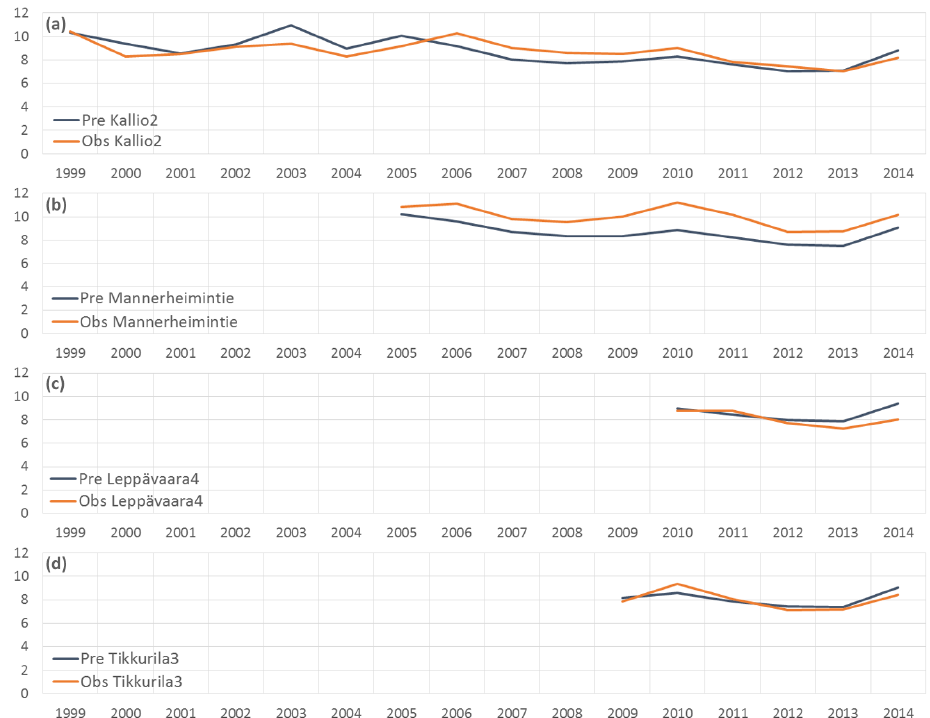
Figure B1. The time series of the observed and predicted annual average concentrations of PM 2 . 5 at the four considered urban air quality measurement stations. The predicted time series have been presented only for the periods for which the observations were available. The concentrations have been presented as micrograms per cubic